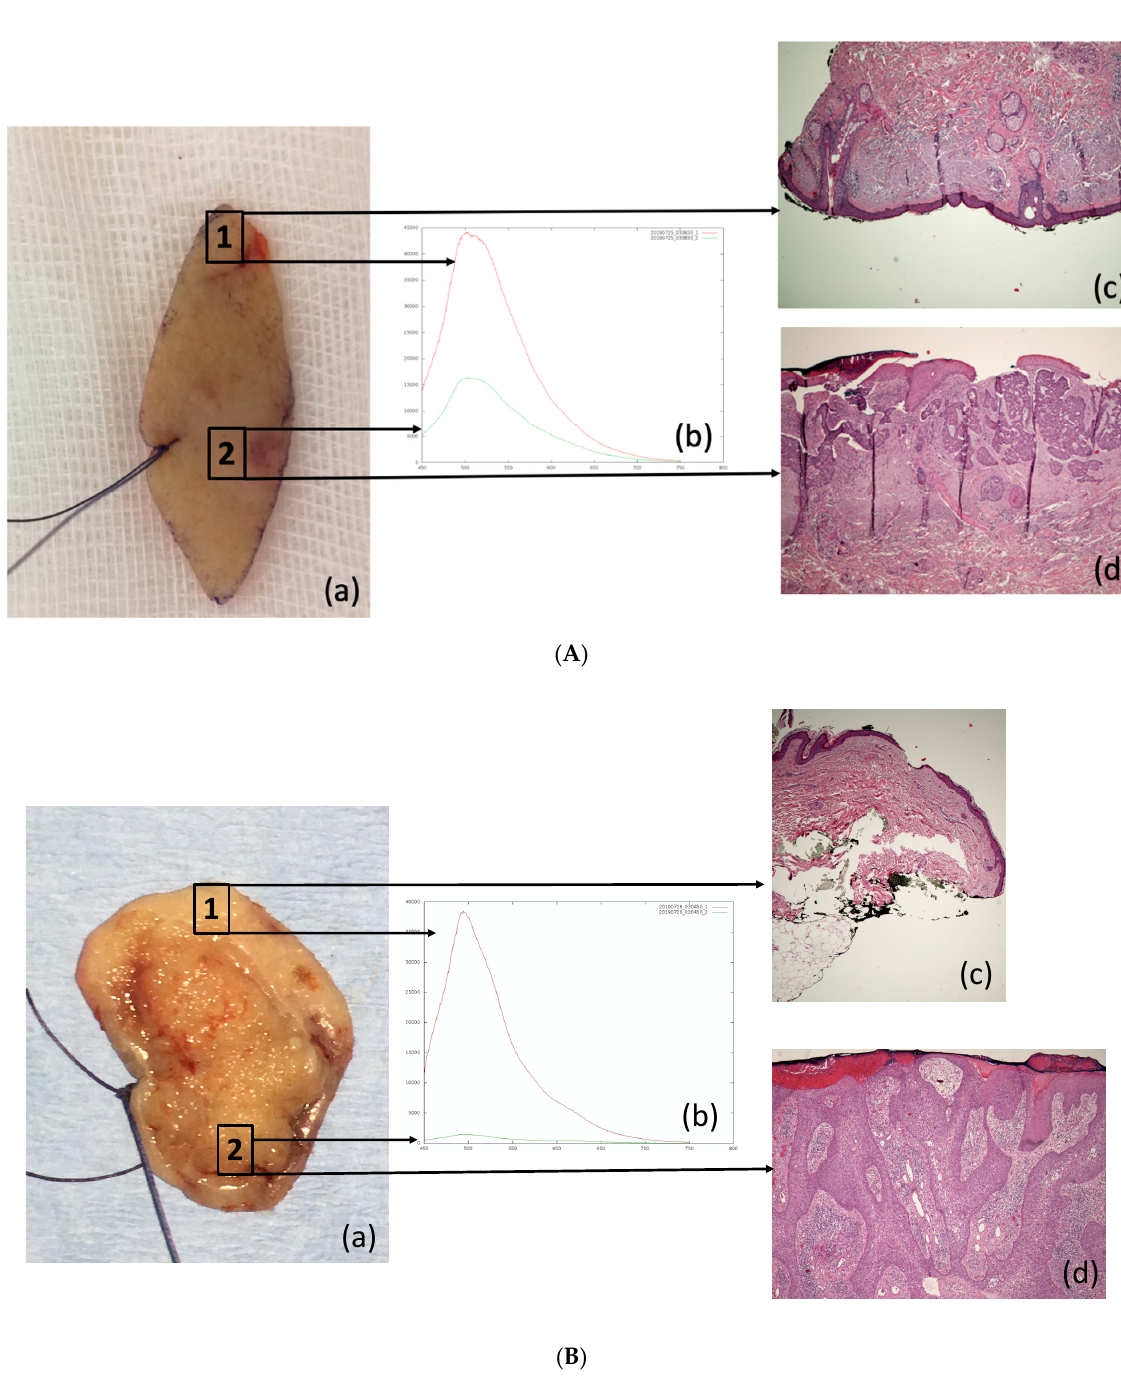
Figure 3. ( A ): Example of clinicopathological correlation of AF alteration in BCC: (a) identification of control point (1) and lesional point (2) on the excised specimen (b) AF emission spectra of point 1 (red line) and point 2 (green line) (c) histopathological section (hematoxylin and eosin, 4× magnification) corresponding to point 1 healthy skin, (d) histopathological section (hematoxylin and eosin, 4× magnification) corresponding to point 2 (infiltrating BCC). ( B ): Example of clinicopathological correlation of AF alteration in SCC: (a) identification of control (1) and lesional points (2); (b) AF emission spectra of point 1 (red line) and point 2 (green line); (c) histopathological section (hematoxylin and eosin, 4× magnification) corresponding to point 1 (healthy skin), (d) histopathological section (hematoxylin and eosin, 4× magnification) corresponding to point 2 (poorly differentiated SCC).